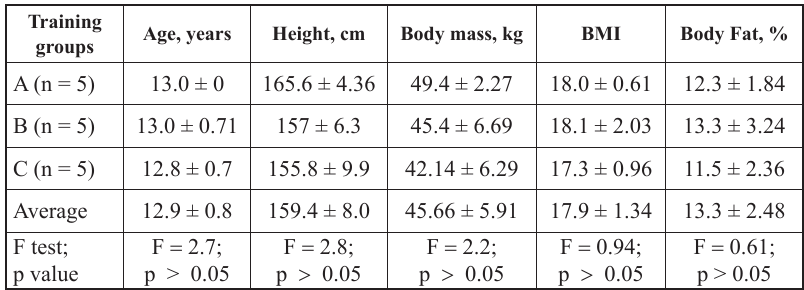
Table 1. Anthropometric characteristics of subjects ( x ±